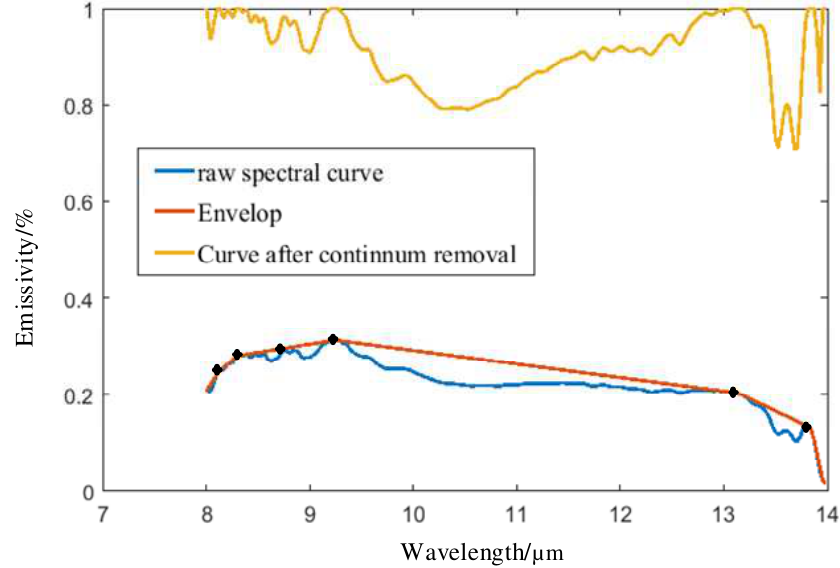
Figure 4. Illustration of continuum removal.